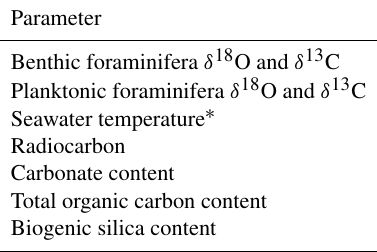
Table 1. Palaeoclimate parameters in the PalMod 130k marine data